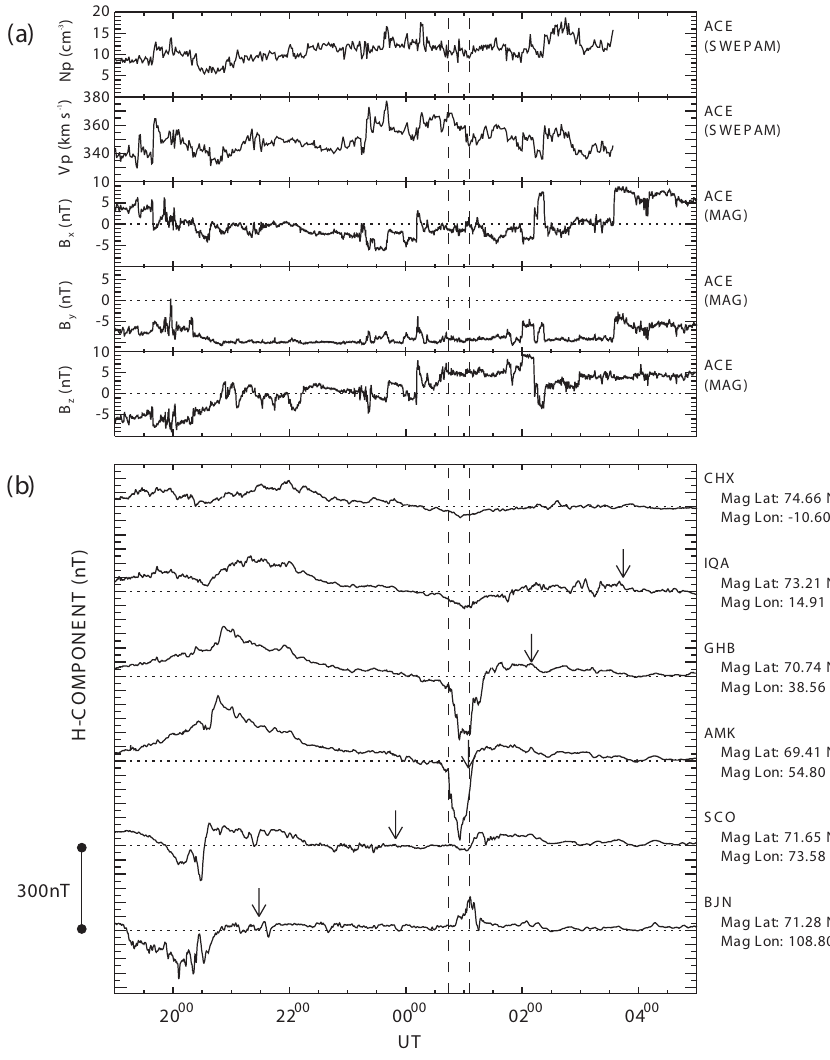
Fig. 2. (a) Upstream interplanetary observations from the ACE spacecraft, lagged by 74min to account for the propagation delay to the ionosphere. The top two panels show solar wind density and velocity data, while the bottom three panels show IMF data in GSM coordinates, for 19:00UT on 1 December to 05:00UT on 2 Decem- ber 1999. The times of substorm ex- pansion phase onset and recovery on- set are marked with vertical dashed lines. (b) Shows H -component mag- netic field measurements from the az- imuthal magnetometer array shown by the red dots in Fig. 1b. The separation between magnetometer baselines (hor- izontal dotted lines) is 300nT. These baselines have been taken as the field measured at each station at 04:00UT, as discussed in the text. Vertical arrows in- dicate the time of magnetic local mid- night. Magnetic midnight for station CHX occurs at ∼ 05:26UT, just beyond the interval